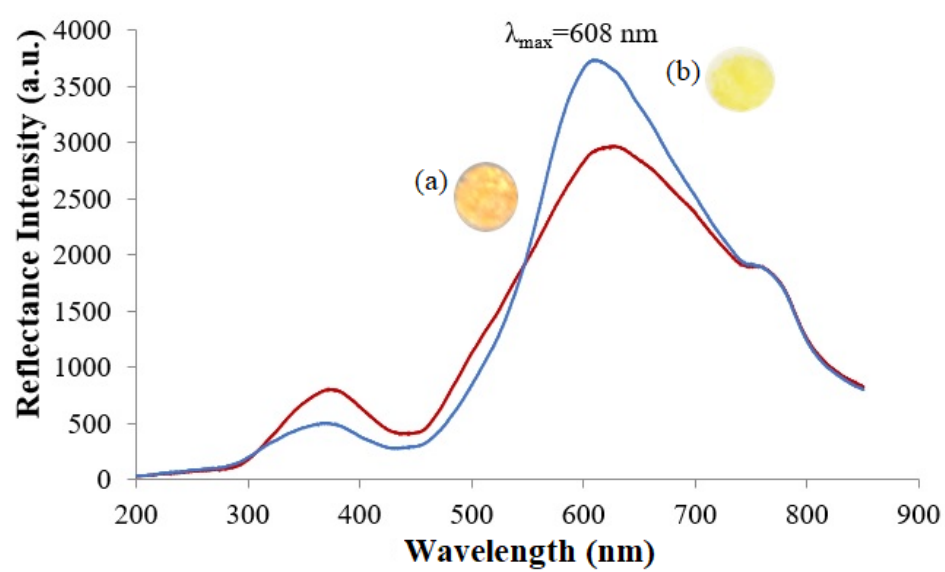
Figure 4. Reflectance spectra of the Ru(II) complex-modified biomimetic nanosilica support ( a ) before and ( b ) after reaction with 100 mg L − 1 nitrite in 0.1 M K-phosphate buffer at pH 7.4. The bio-doped microbial nanosilica exhibited a maximum reflectance peak signal at 608 nm, and the reflectance peak signal significantly heightened due to the deprotonation of phen-BT ligands in the ruthenium complex, while the intracellular enzyme expression system catalyzed the enzymatic reduction of nitrite.